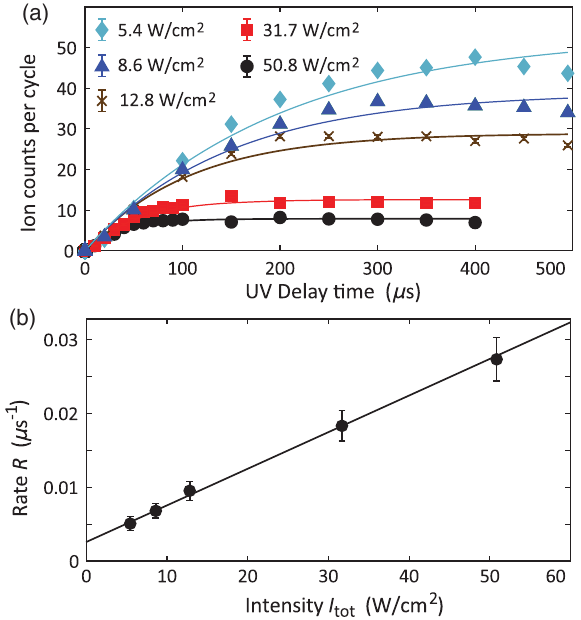
FIG. 4. Lifetime of the KRb 2 (cid:1) collision complex. (a) Time evolution of the KRb 2 (cid:1) population (measured via the KRb 2 þ ion signal) after a rapid change in the 1064 nm intensity, for different values of I . Data are normalized by the corresponding number tot of experimental cycles ( ∼ 100 for each data point). The time- averaged value of the total intensity is fixed at 11 . 3 kW = cm 2 across all datasets. Error bars represent shot noise, and the solid lines are fits using the function A ð 1 − e − Rt Þ . (b) Characteristic growth rate R of the complex population, as obtained from the fits in (a), versus the corresponding total ODT intensity. Error bars represent the 1 σ statistical uncertainty in the fitted value of R , and the solid line is a linear fit to the data. All data shown in (a) and (b) are taken with B ¼ 30 G and E ¼ 17 V =